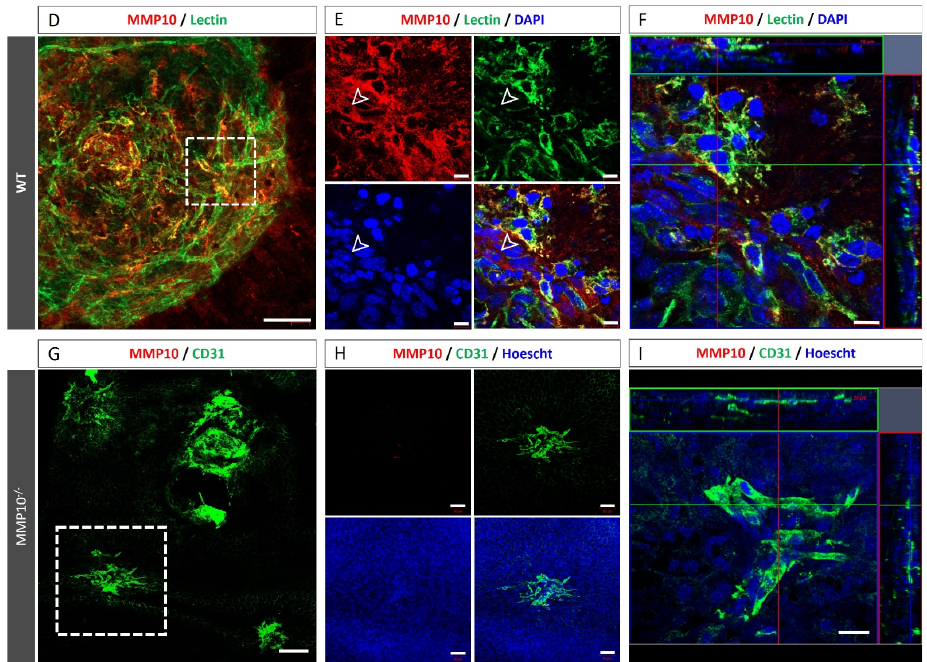
Figure 4. Endothelial cells (ECs) of laser-induced CNV areas are positive for MMP10 staining. Representative laser-induced CNV lesions on choroidal flat-mounts from WT mice stained with MMP10 (red), lectin or CD31 (green). ( A ) Whole flat-mount micrograph with three successfully induced CNV around the optic nerve, the outlined region represents the CNV shown in ( B – F ). ( B ) Magnification of dotted square in CNV area. MMP10 expression is increased in the CNV area. ( C ) Orthogonal view of the obtained z-stack showing that MMP10 expression is localized over the RPE Upper orthogonal projection showed a RPE nuclei disorganization and right orthogonal projection showed disruption in RPE nuclei (*). ( D ) Magnification of the same CNV in which the outlined region represents the magnification shown in E and F. ( E ) Magnification (63 × ) inside the CNV area showing that the endothelium (green) is positive for MMP10 (red). Some MMP10 positive cells are lectin nega- tive (white arrow). ( F ) Orthogonal view of the obtained z-stack. ( G ) Whole flat-mount micrograph of a MM10 -/- mice with laser-induced CNV. The outlined region represents the CNV shown in H and I. ( H ) Magnification of the CNV in a MM10 -/- mice, as expected, no MMP10 expression is detected. ( I ) Orthogonal view of the obtained z-stack. Hoescht and 4 (cid:48) ,6-diamidino-2-phenylindole (DAPI) (blue) label nuclei. CNV = Choroidal neovascularisation. MMP10 = Matrix metalloproteinase 10. ON = optic nerve. WT = wild type. Scale bars: 10 µ m ( E , F ), 20 µ m (I), 50 µ m ( B – D , H ), 100 µ m ( G ) and 500 µ m ( A